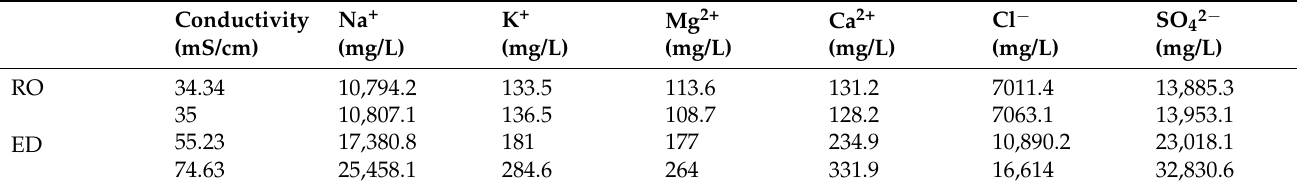
Table 3. The main components for different solution